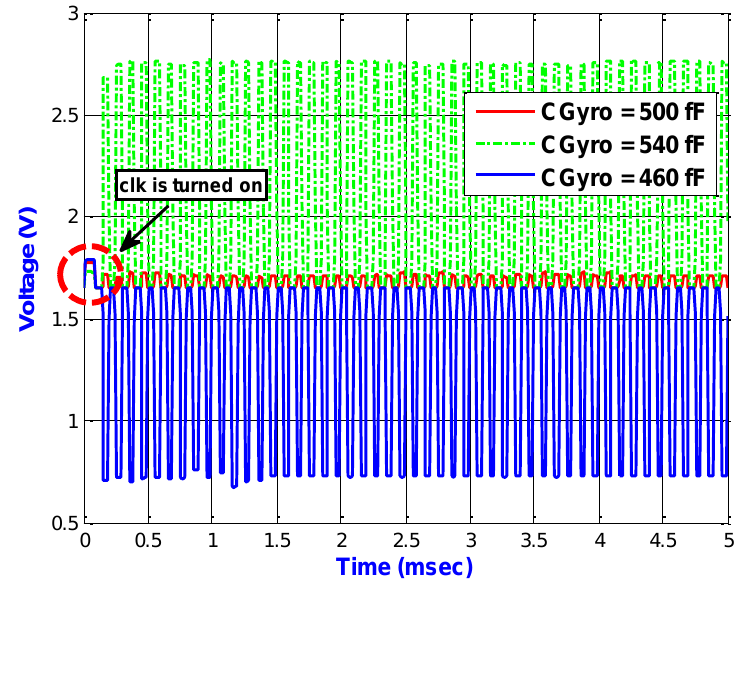
Figure 15. Output results of the proposed PISC circuit under different C C = 60 Elec